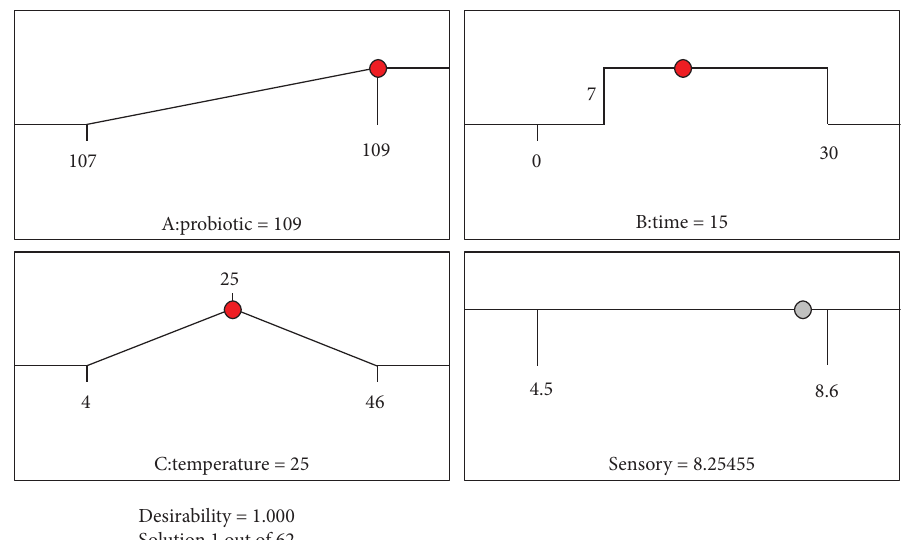
Figure 11: Optimization values of probiotic content, temperature, and storage time of pistachio paste on overall